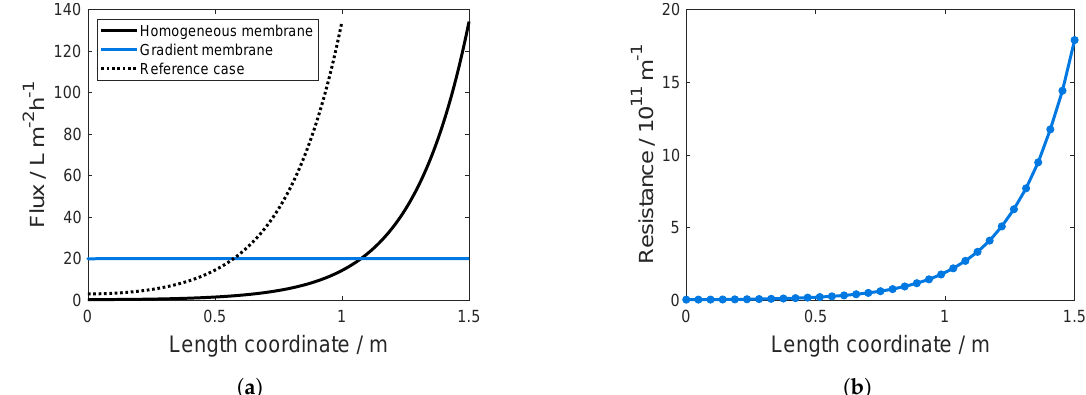
Figure 5. Optimization of membrane fiber with an increased length of 1.5 m and comparison to reference case with a length of 1 m; flux profiles J ( x ) ( a ) and optimized resistance profile R m ( x ) ( b